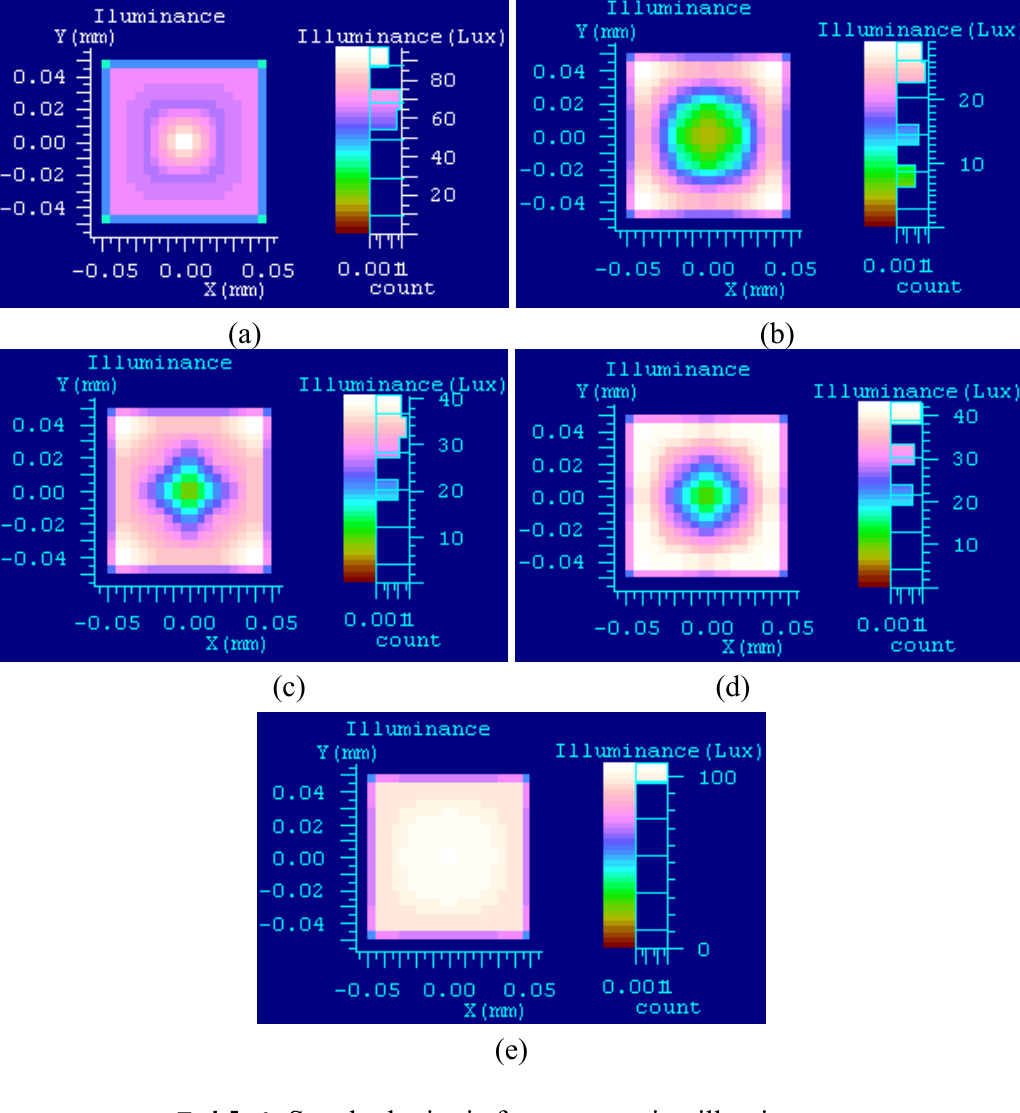
Table 1. Standard criteria for target region